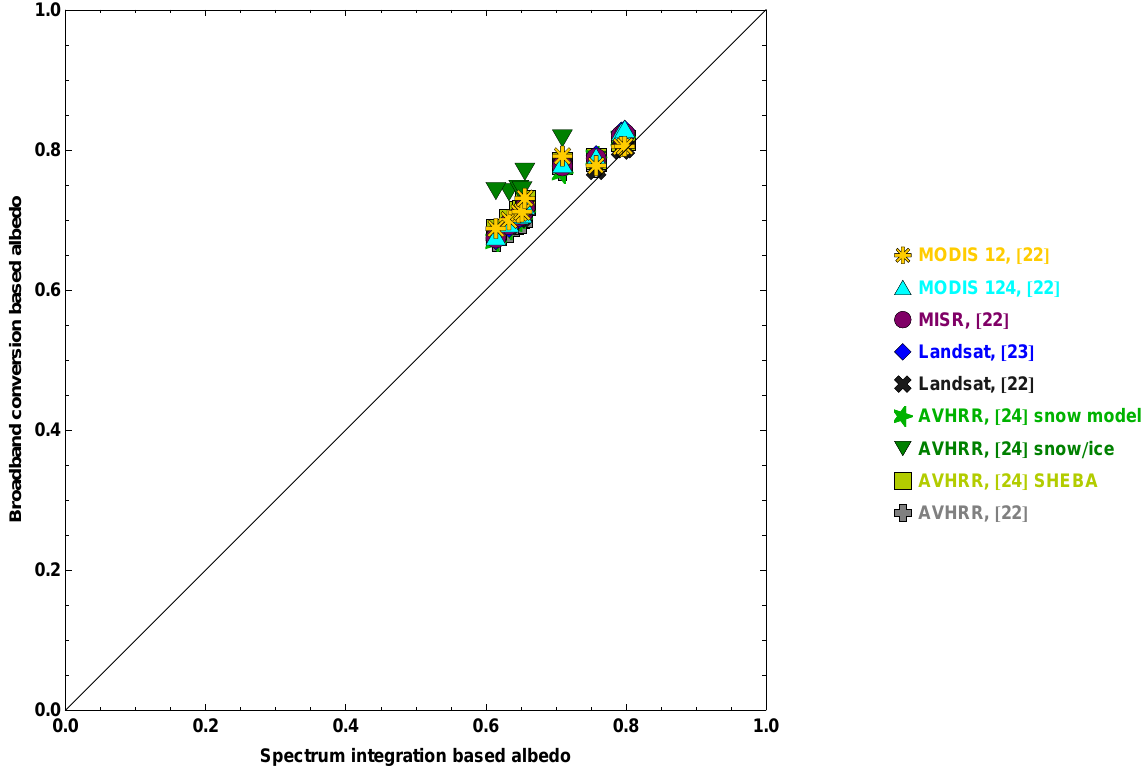
Figure 12. The albedo calculated using broadband conversion methods versus the integrated measured BRF spectrum for various targets and the sun zenith angle values. The dedicated snow conversion methods developed by Greuell and Oerlemans, Knap and Oerlemans and Xiong et al . [22–24] are colour-coded as shown and the target is snow for all